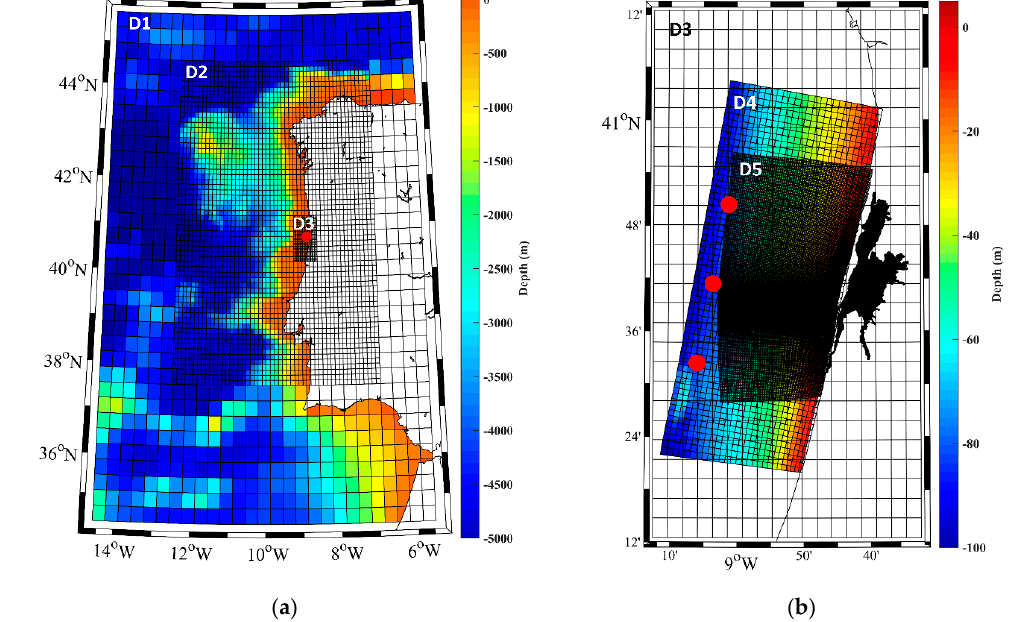
Figure 2. Study area with the extents of the numerical domains and bathymetry used for SWAN implementations, the downscale of the BCC-CSM1.1 GCM ( a ) using a nested approach (D1, D2, and D3), and the wave propagation in the hydrodynamic model ( b ) in the study area (D4 and D5). The red dots indicate the grid nodes assessed in terms of wave parameters to determine the return periods.